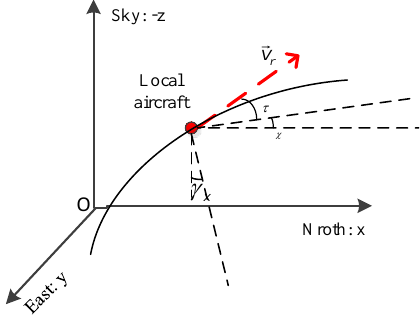
Figure 1. The geometric situation of combat.